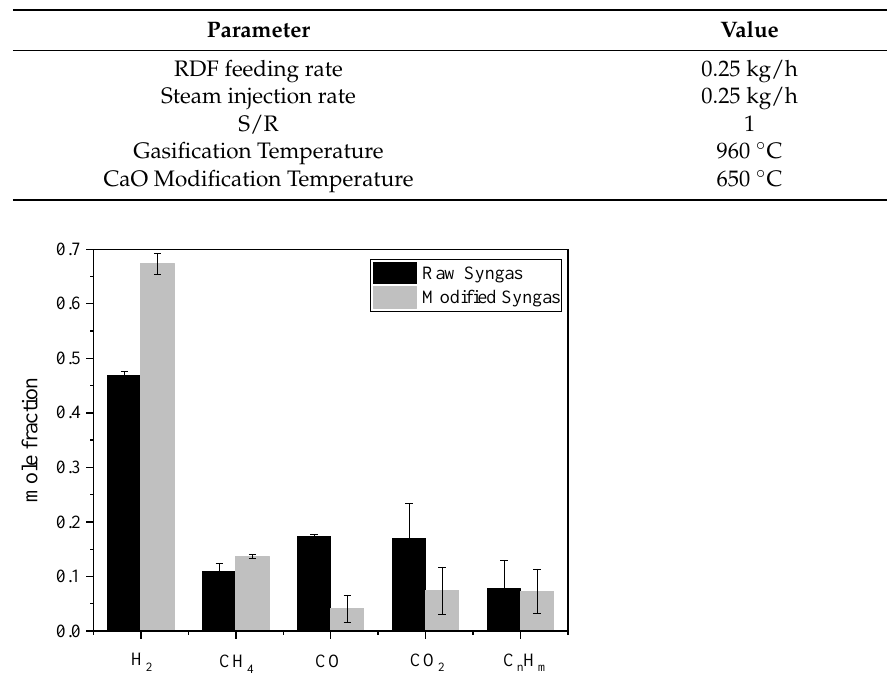
Table 3. Operational Parameters for RDF gasification system.